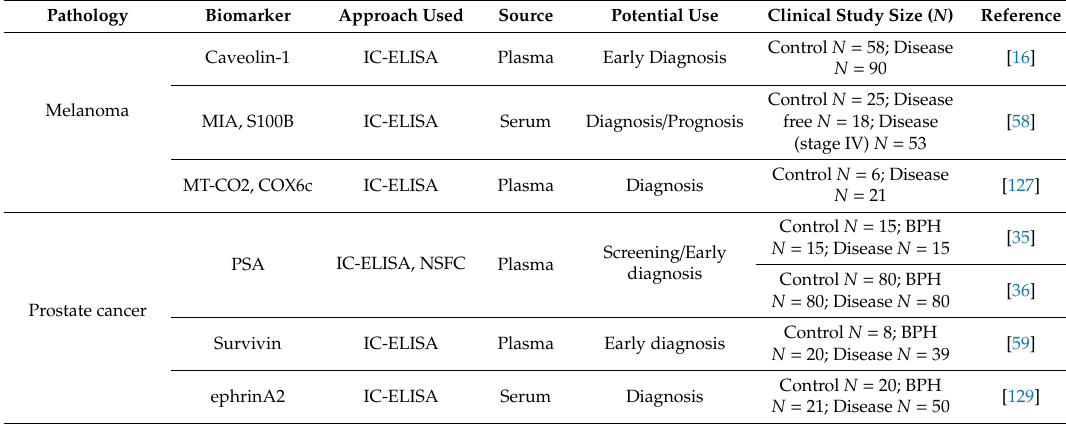
Table 3. Detection of exosomal tumor biomarkers in body fluids by immunocapture-based ELISA